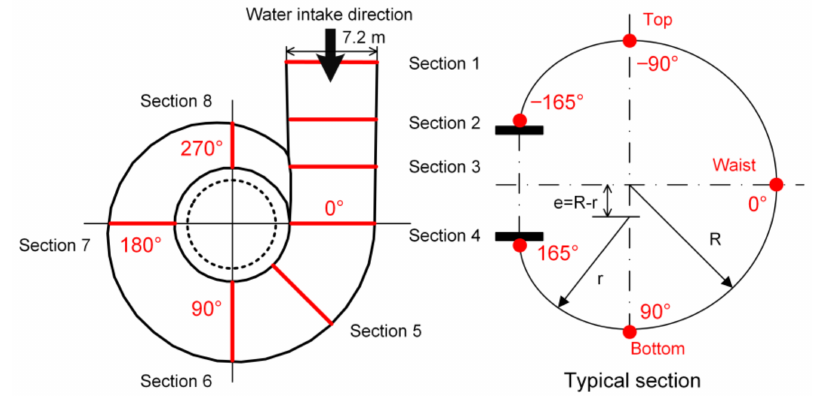
Figure 4. The plain layout and typical section of the SSC.